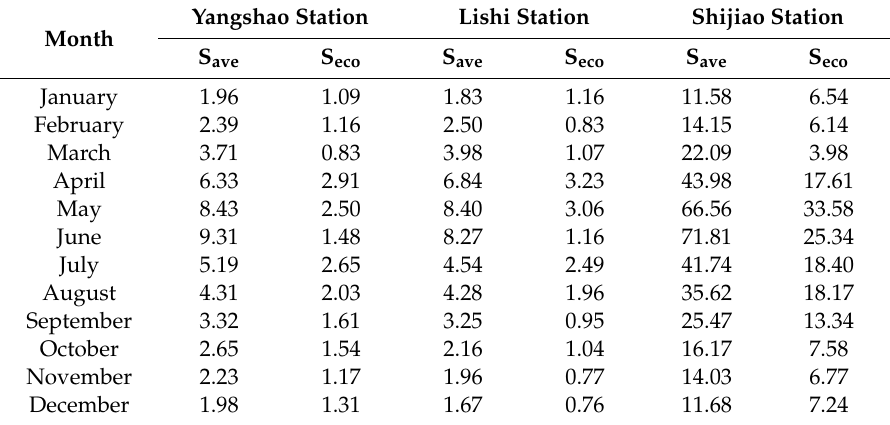
Table 6. The monthly average runo ff (S ave ) and the water demand (S eco ) in each